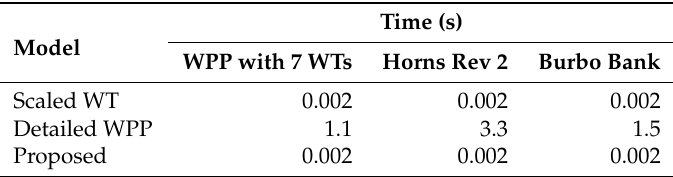
Table 4. Time required for three reactive power capability models.